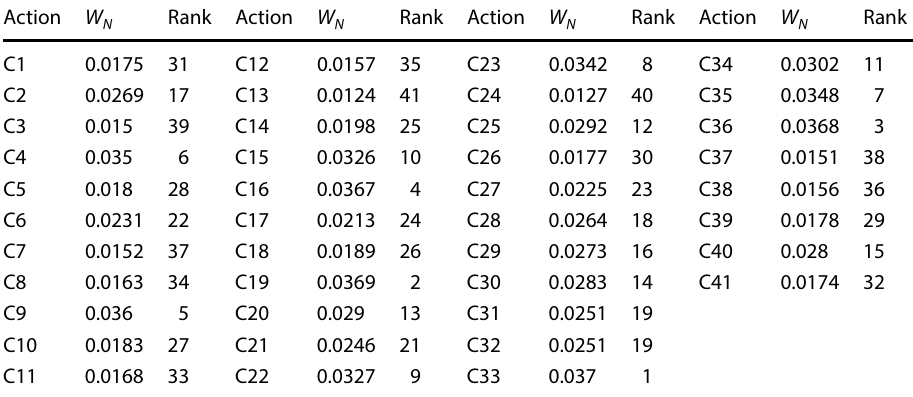
Table 11 Normalized weight of